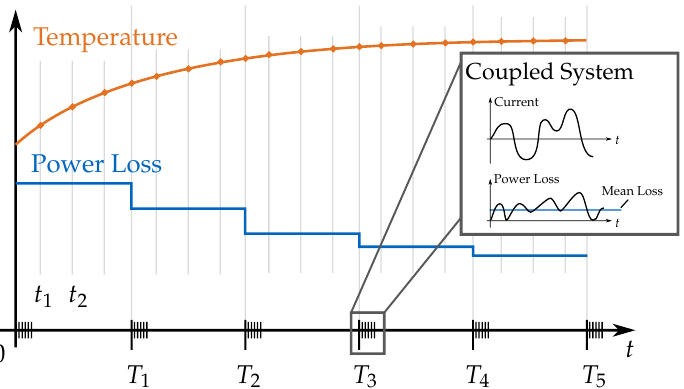
Figure 5. Time integration strategy with t i being the magnetodynamic period and T j denoting the large timestep used for the time integration of the thermodynamic model The time integration itself is performed using the backward Euler algorithm with k indicating the timestep. For the magnetodynamic domain eq. (11), the solution u